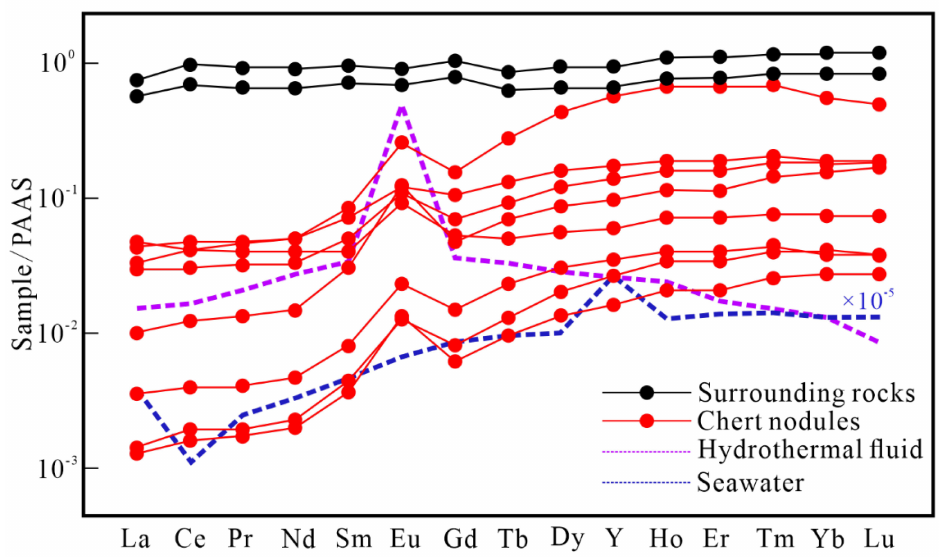
Figure 8. Post − Archean − Australia − Shale (PAAS) − normalized rare earth element and yttrium values of chert nodules in the Lucaogou Formation, surrounding rocks in the Lucaogou Formation, hydrothermal fluid [73] and seawater